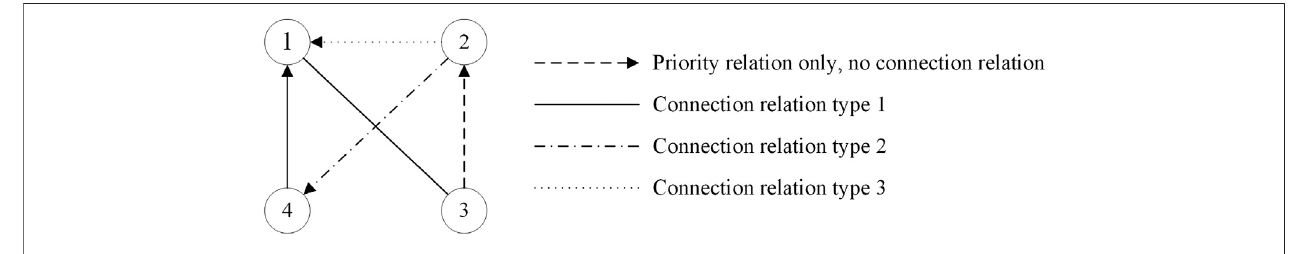
FIGURE 1 | Disassembly relationship hybrid